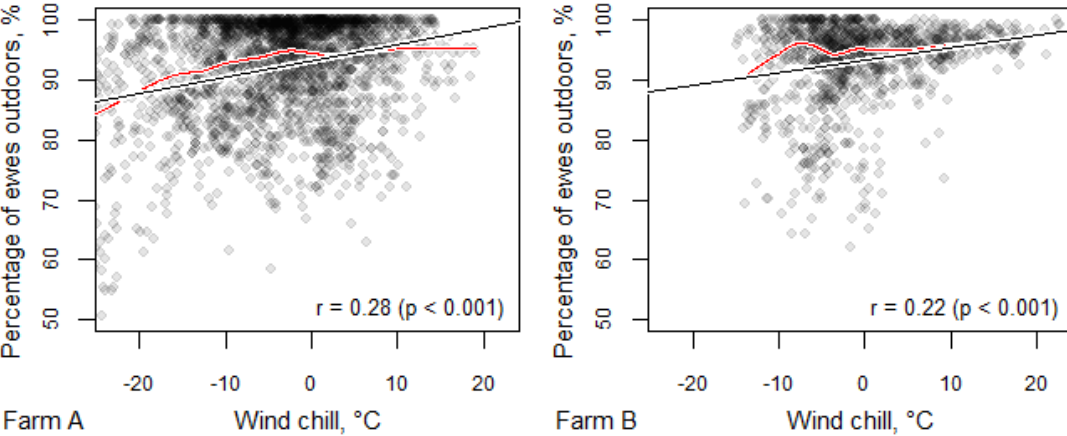
Figure 3. Percentage of ewes outdoors dependent on wind chill. One point corresponds to one photograph, black lines denote the linear relationship (corresponding correlation coefficients with p -values are presented in the lower right corners of the figures) and the red lines indicates the potential non-linear relationship fitted with a locally weighted scatterplot smoothing (LOWESS) curve.